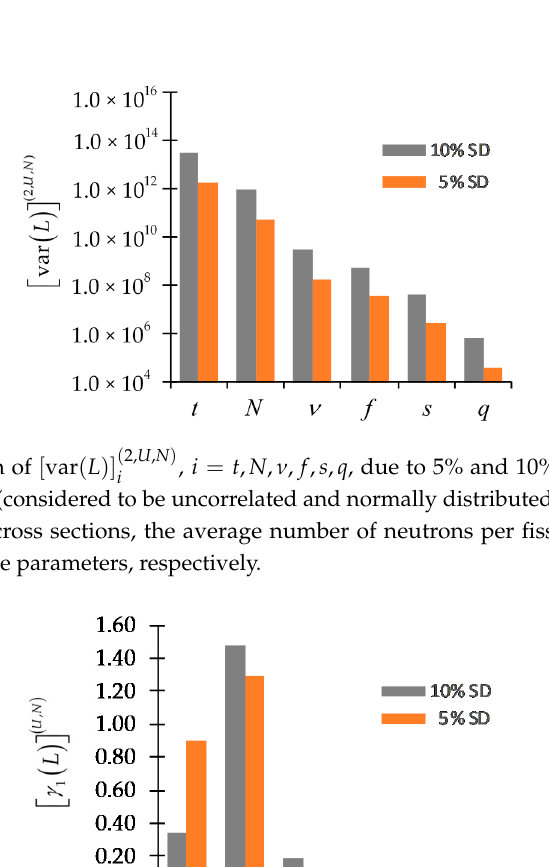
Figure 11. Comparison of [ γ 1 ( L )] , i = t , N , ν , f , s , q , due to 5% and 10% standard deviations (SD) of the parameters (considered to be uncorrelated and normally distributed) underlying the total, scattering and fission cross sections, the average number of neutrons per fission, isotopic number densities, and the source parameters, respectively.